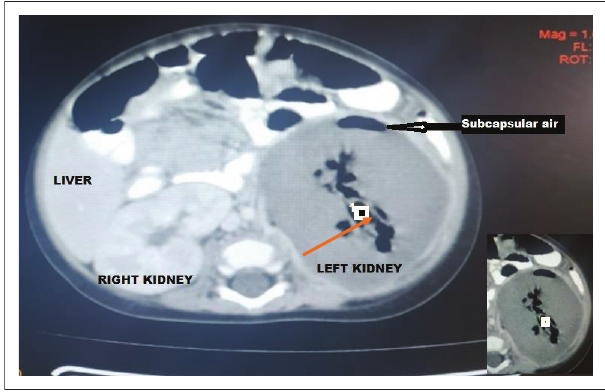
FIGURE 2: Contrast enhanced computed tomogram of an emphysematous pyelonephritis patient at the Usmanu Danfodiyo University Teaching Hospital, Sokoto, Nigeria, November 2019. Figure shows left renomegaly, contrast enhancement and multiple air densities within the calyceal system (orange arrow).